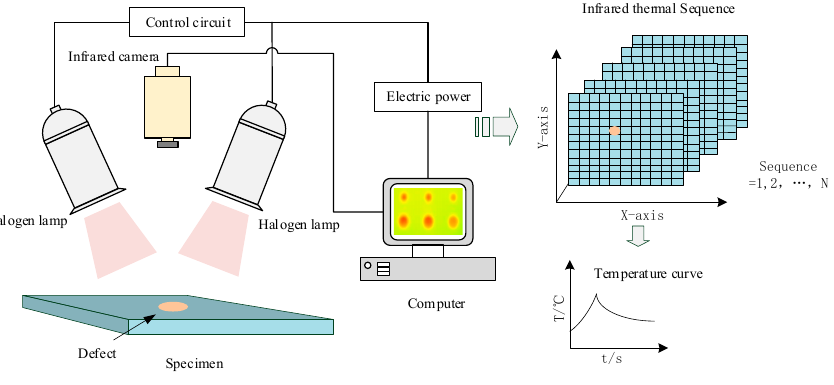
Figure 7. The experimental system.